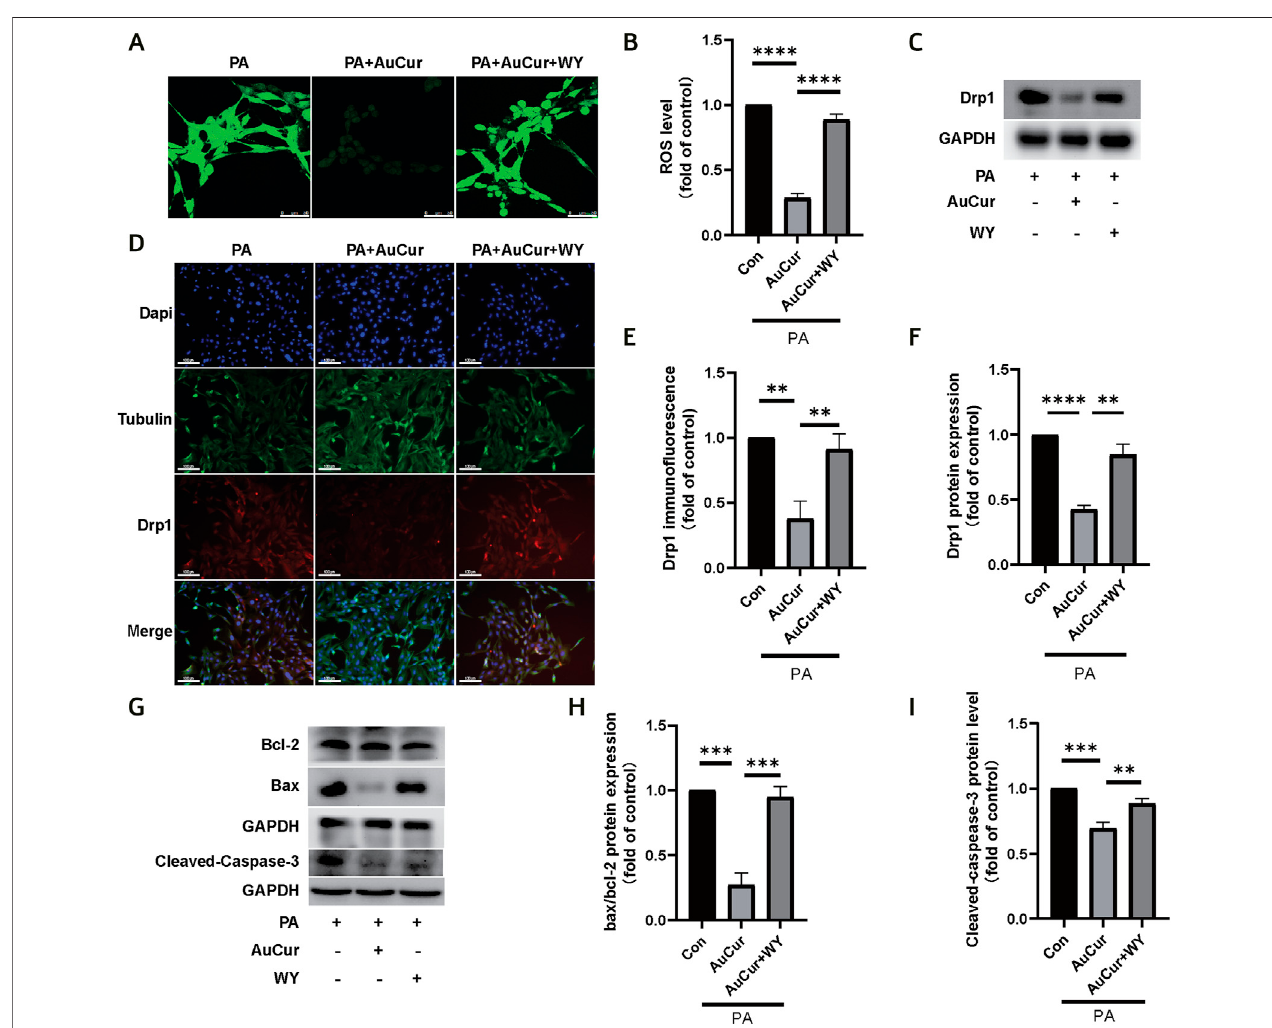
FIGURE 7 | AuCur regulates PPAR α to treat PA-induced ROS elevation, mitochondrial damage, and apoptosis. (A) ROS confocal staining images of PA, PA + AuCur,andPA+AuCur+WY.Scalebar:50 μ m. (C) Drp1expressionwasdetectedbyWB.GAPDHwasusedasaninternalreference. (D) Drp1 fl uorescenceanalysisof PA,PA+AuCur,andPA+AuCur+WYgroups.Scalebar:100 μ m. (B) ROSimageanalysis. (F) BandinganalysisofDrp1. (E) Drp1 fl uorescenceimageanalysis. (G) WB was used to detect the expression of Bax, Bcl-2, and Cleaved-caspase-3. GAPDH was used as an internal reference. (H – I) Bax, Bcl-2, and Cleaved-caspase-3 bands were analyzed. * p <